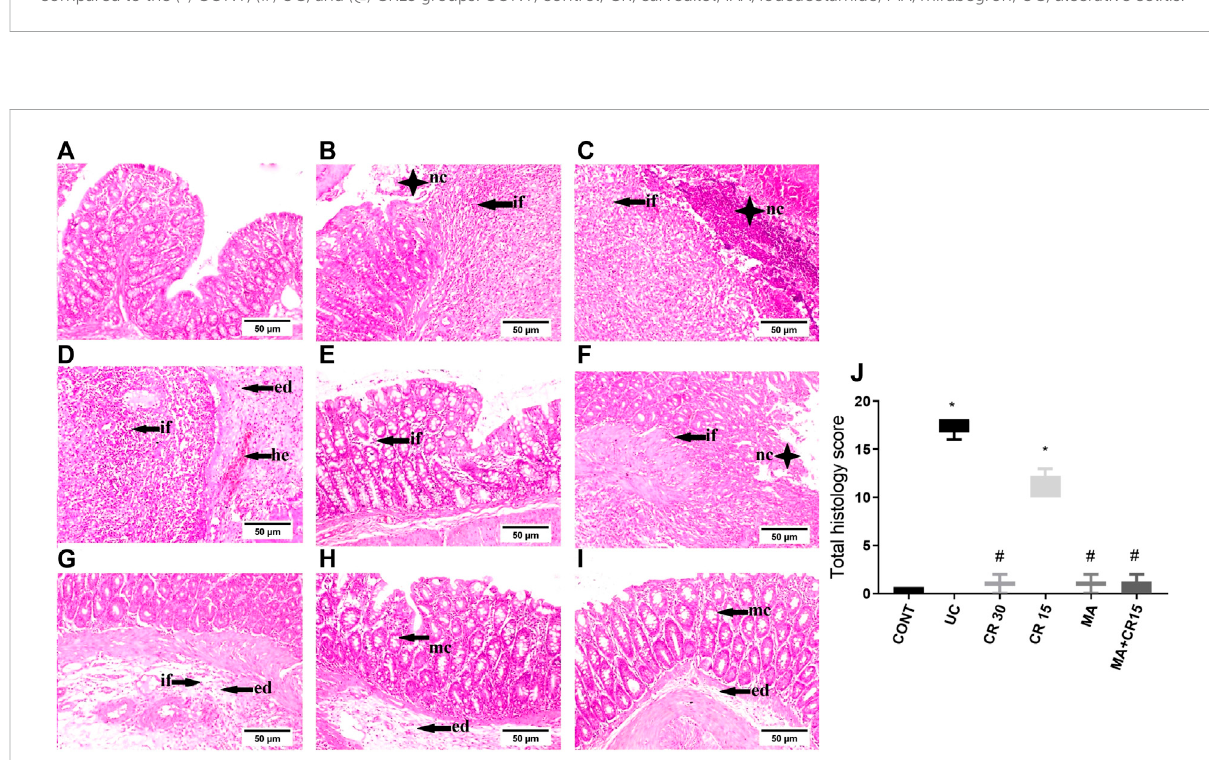
FIGURE 2 Effect of mirabegron and/or carvedilol on colon histopathological changes and total lesions score in rats with IAA-induced ulcerative colitis. Representative photomicrographs (H&E; scale bar, 50 μ m) of the (B – D) UC model show marked mucosal necrosis (nc), massive in fl ammatory cells in fi ltration (if), marked edema (ed), and focal hemorrhage (he), compared to the section of the (A) CONT group that reveals normal morphology. Sectionof (E) CR30showsfewin fl ammatorycellsin fi ltrationinthelaminapropria,whereas,sectionsof (F,G) CR15depictmucosal/submucosal focal necrosis associated with in fl ammatory cells in fi ltration, fi broblasts proliferation, and submucosal edema. Treatment with (H) MA and (I) MA+CR15revealshyperplasiaofmucous-secreting glands(mc)andslightsubmucosal edema. (J) representstotallesionscoring.Dataarepresented as median (min-max) (5 fi elds in each section, n = 3 rats/group); the data were analyzed using Kruskal-Wallis followed by Dunn ’ s posthoc test; p < 0.05. As compared to the (*) CONT and (#) ulcerated groups. CONT, control; CR, carvedilol; ed, edema; he, hemorrhage; if, in fl ammatory cells in fi ltration; IAA, iodoacetamide; nc, necrosis; MA, mirabegron; mc, mucous secreting glands; UC, ulcerative